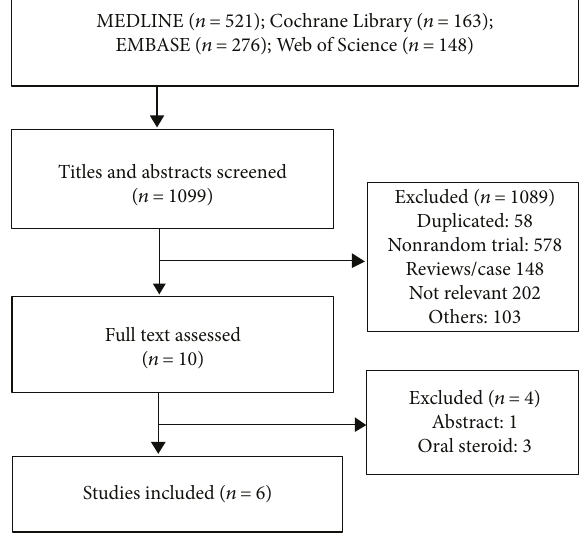
Figure 1: Flow chart of trial selection